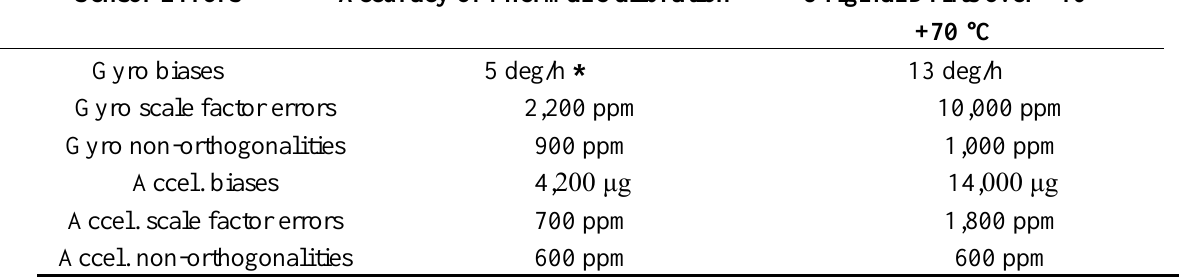
Table 7. Calibration accuracy of proposed method (reference to Soak method) and the original thermal drift ranges of the sensor errors over the whole temperature range (with